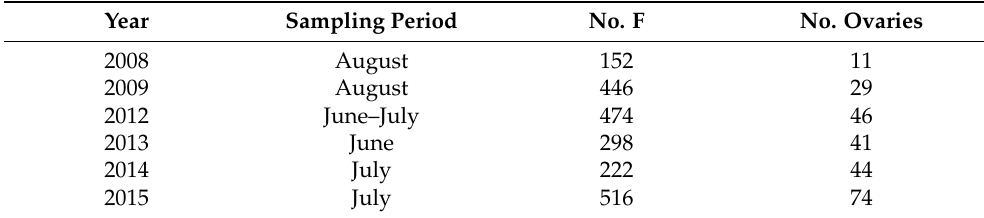
Table 1. Sampling month, number of anchovy females (No. F), and a number of ovaries (No. Ovaries) histologically examined for postovulatory follicle (POF) evaluation and measuring, per sampling year.